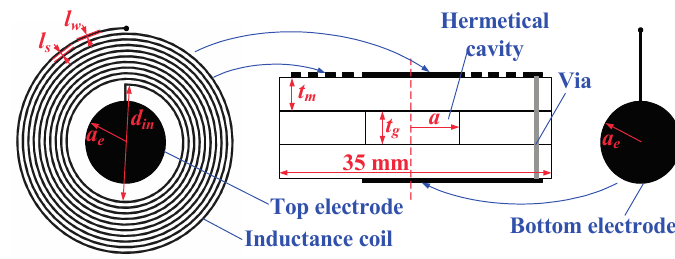
Figure 2. Cross-sectional model and layout of the